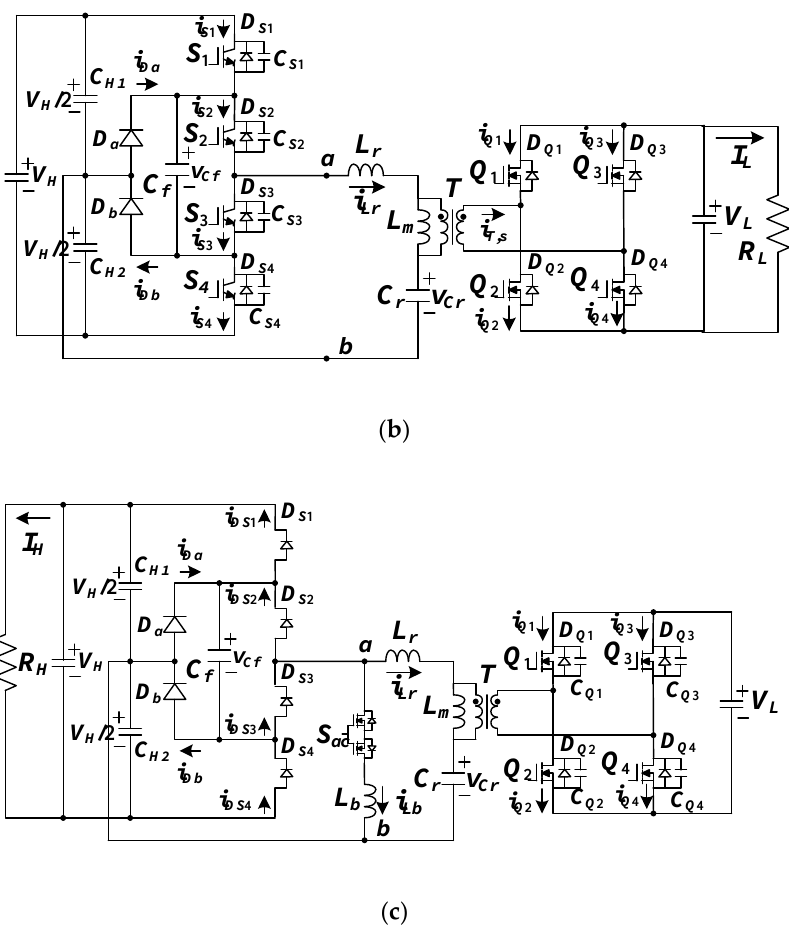
Figure 1. Proposed converter ( a ) converter structure ( b ) forward power flow operation ( S ac off) ( c ) backward power flow operation ( S ac on, S 1 ~ S 4 off).